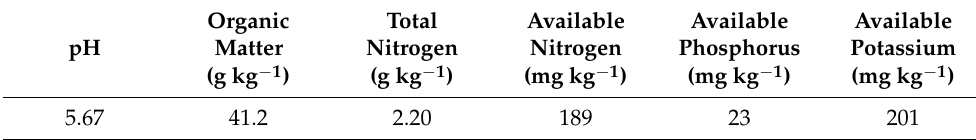
Table 1. Basic physical and chemical characteristics of tested soils. Organic pH